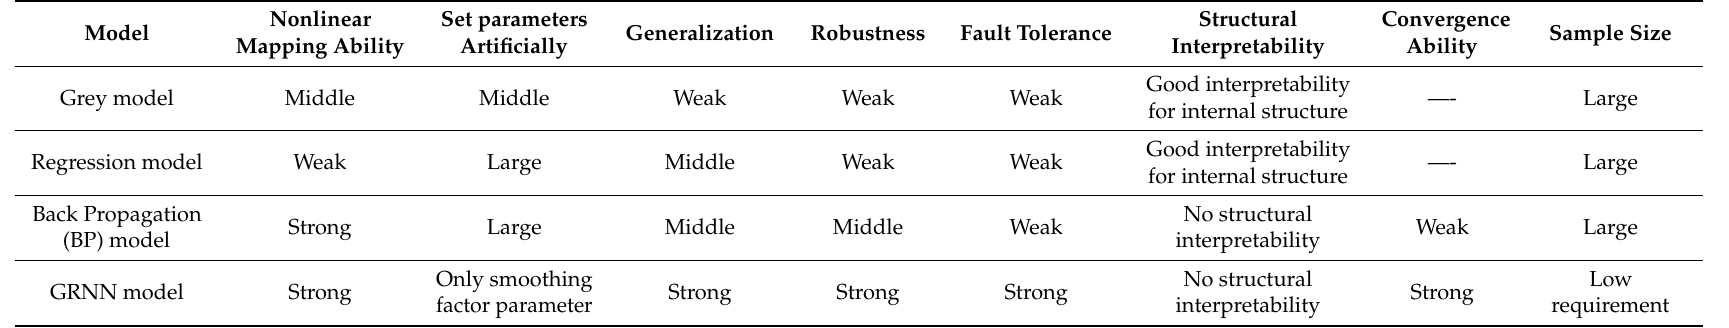
Table 7. Comparison of GRNN with grey model, regression model and BP